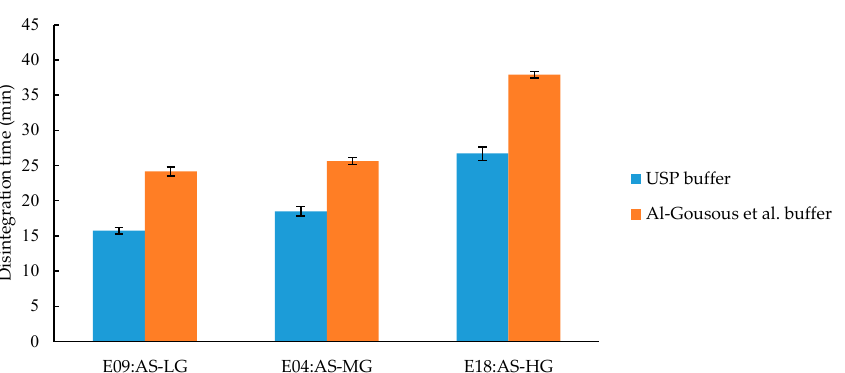
Figure 5. Disintegration time of capsules coated with HPMCAS of different grades (LG, MG, and HG). Given are average disintegration times ± SD; n = 6.